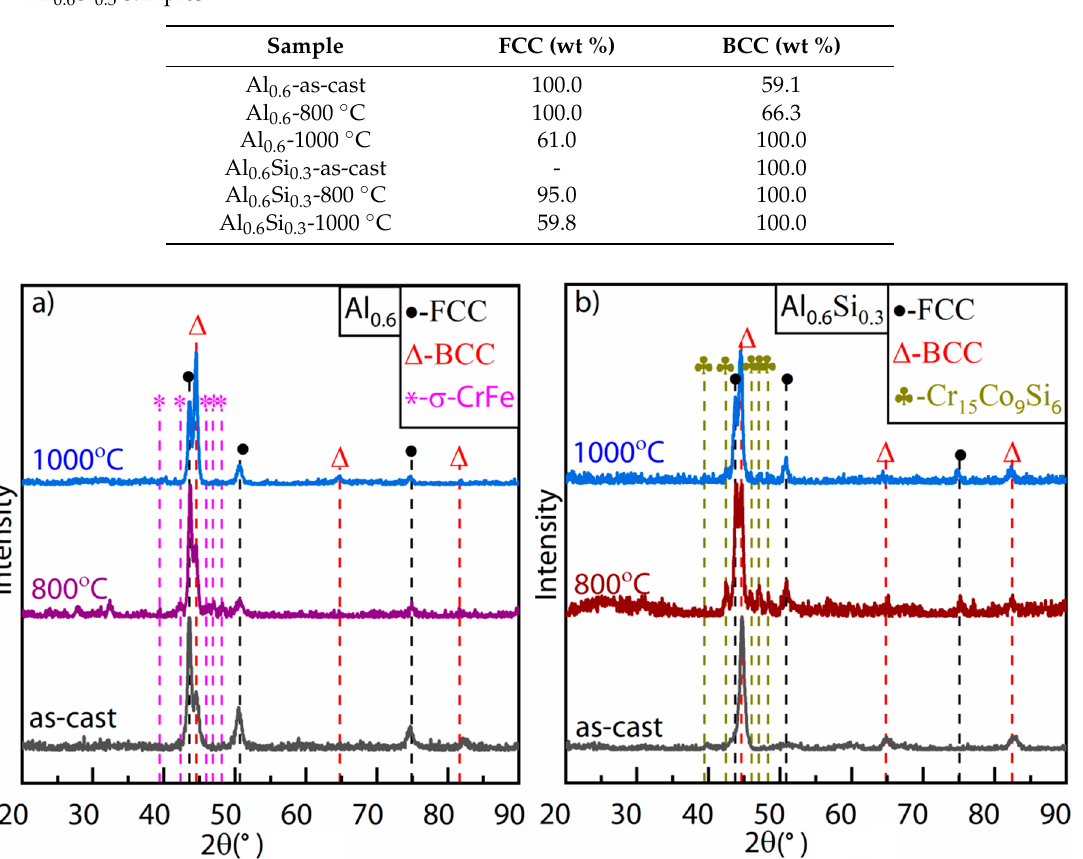
Figure 1. XRD diffraction patterns of Al 0.6 ( a ) and Al 0.6 Si 0.3 ( b ) after the oxidation tests at T = 800 °C, T = 900 °C and T = 1000